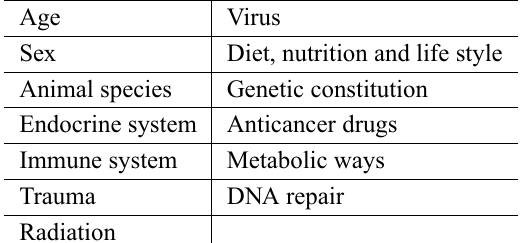
Factors that control and change chemical